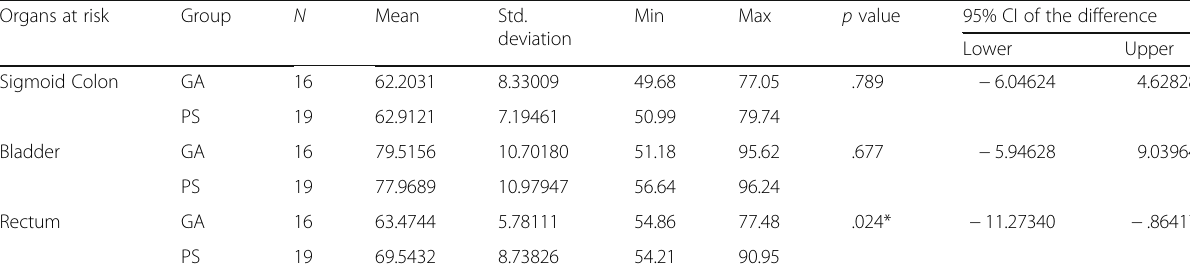
Table 3 EQD2 dose received by 2 cc OARs Organs at